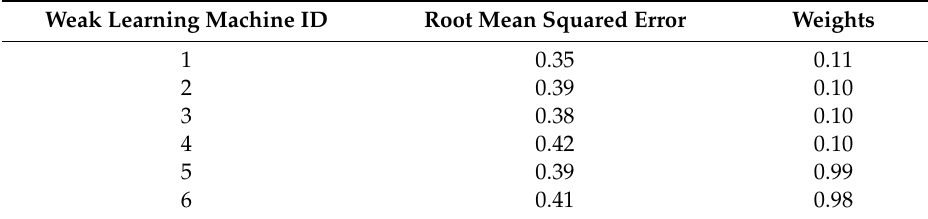
Table 2. Prediction results and weights of each weak learning machine in the AdaBoost-BP algorithm.